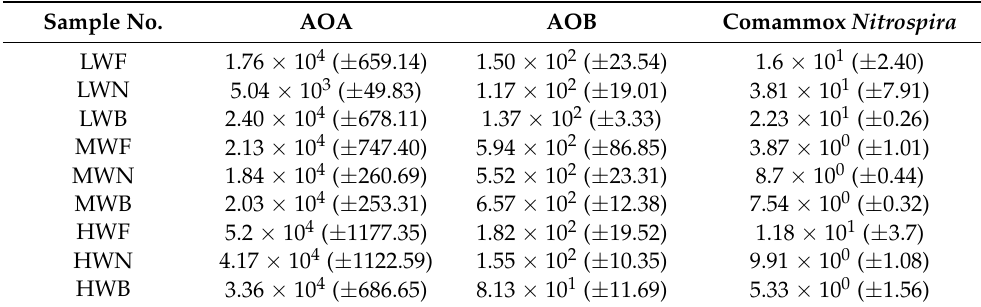
Table 3. Quantitative result of amoA genes of nitrifying microorganisms (planktonic phase) in water samples (copies/mL). Values are shown by average ± standard deviation (n = 3). Sample No. AOA AOB Comammox Nitrospira LWF 1.76 × 10 4 ( ± 659.14) 1.50 × 10 2 ( ± 23.54)